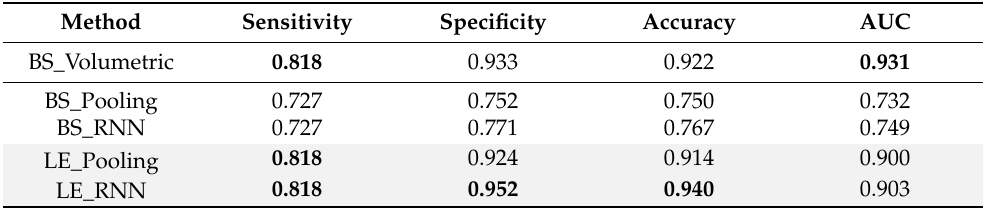
Table 4. Performance of different methods in baseline severity assessment. Bold font indicates best result in each performance metric achieved by the